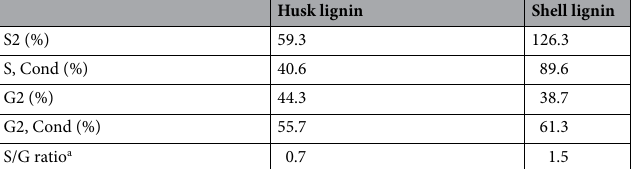
Table 2. Degree of condensation evidenced by S/G ratios for lignins isolated from 1:10 g/g biomass (husk and shell) and [DMBA]